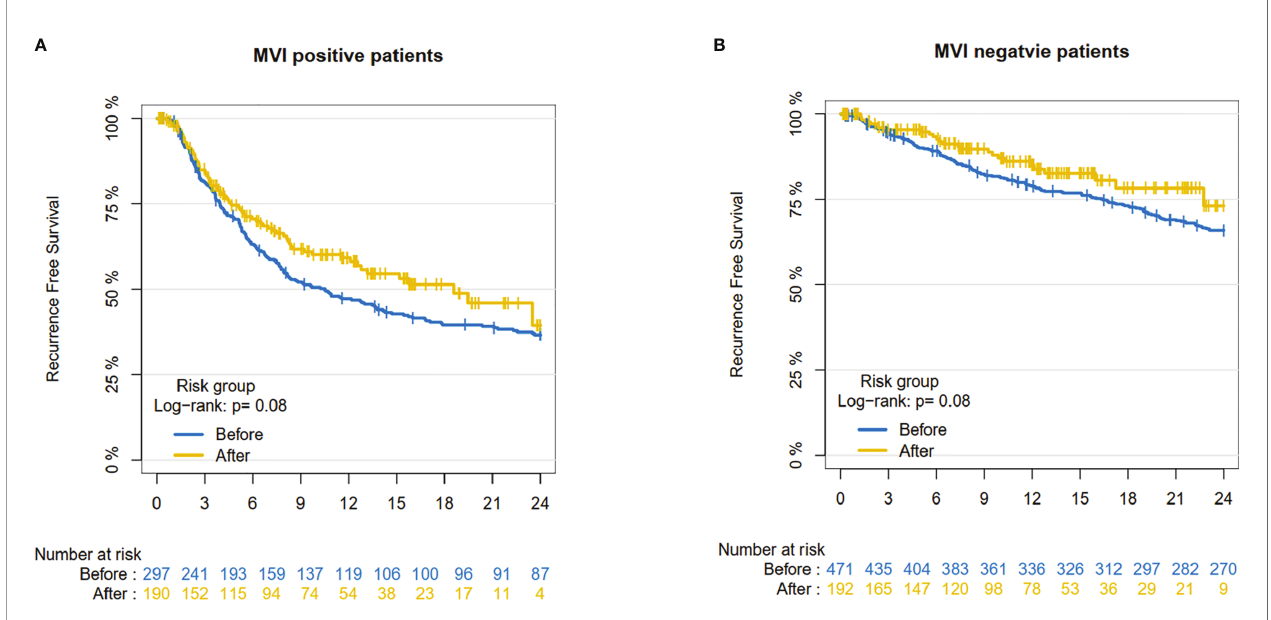
FIGURE 5 | The Recurrence-Free Survival pre- and post-implementation in our center. (A) MVI-negative patients; (B) MVI-positive